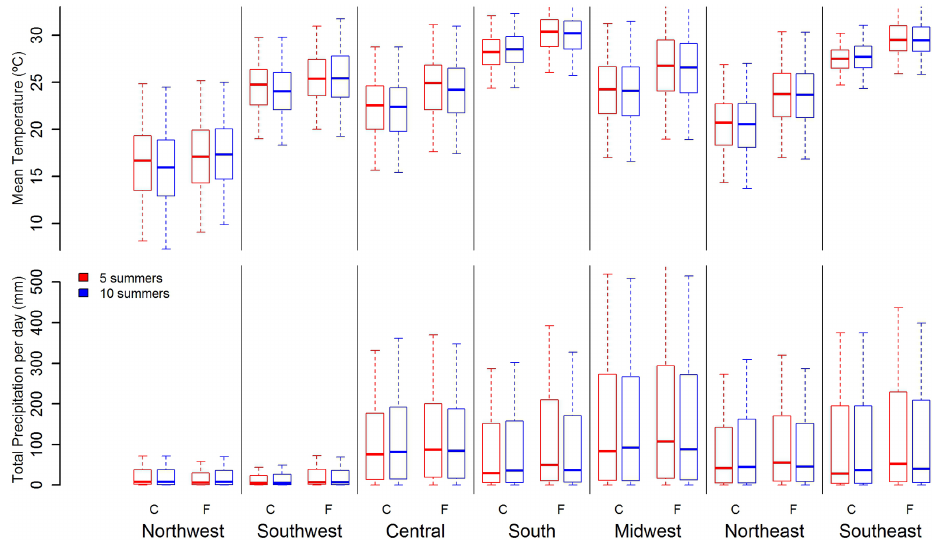
Figure 8. (Top panel) mean regional temperature for the five chosen summers (red) and ten summers (blue) of the current (C) and future (F) decades. (Bottom panel) total regional precipitation per day for the five chosen summers (red) and ten summers (blue) of the current (C) and future (F) decades. Each box-and-whisker indicates median, 5, 25, 75 and 95% quartiles within each region.